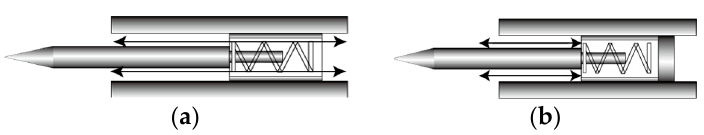
Figure 8. Detailed designs of Type 2 DPIs.